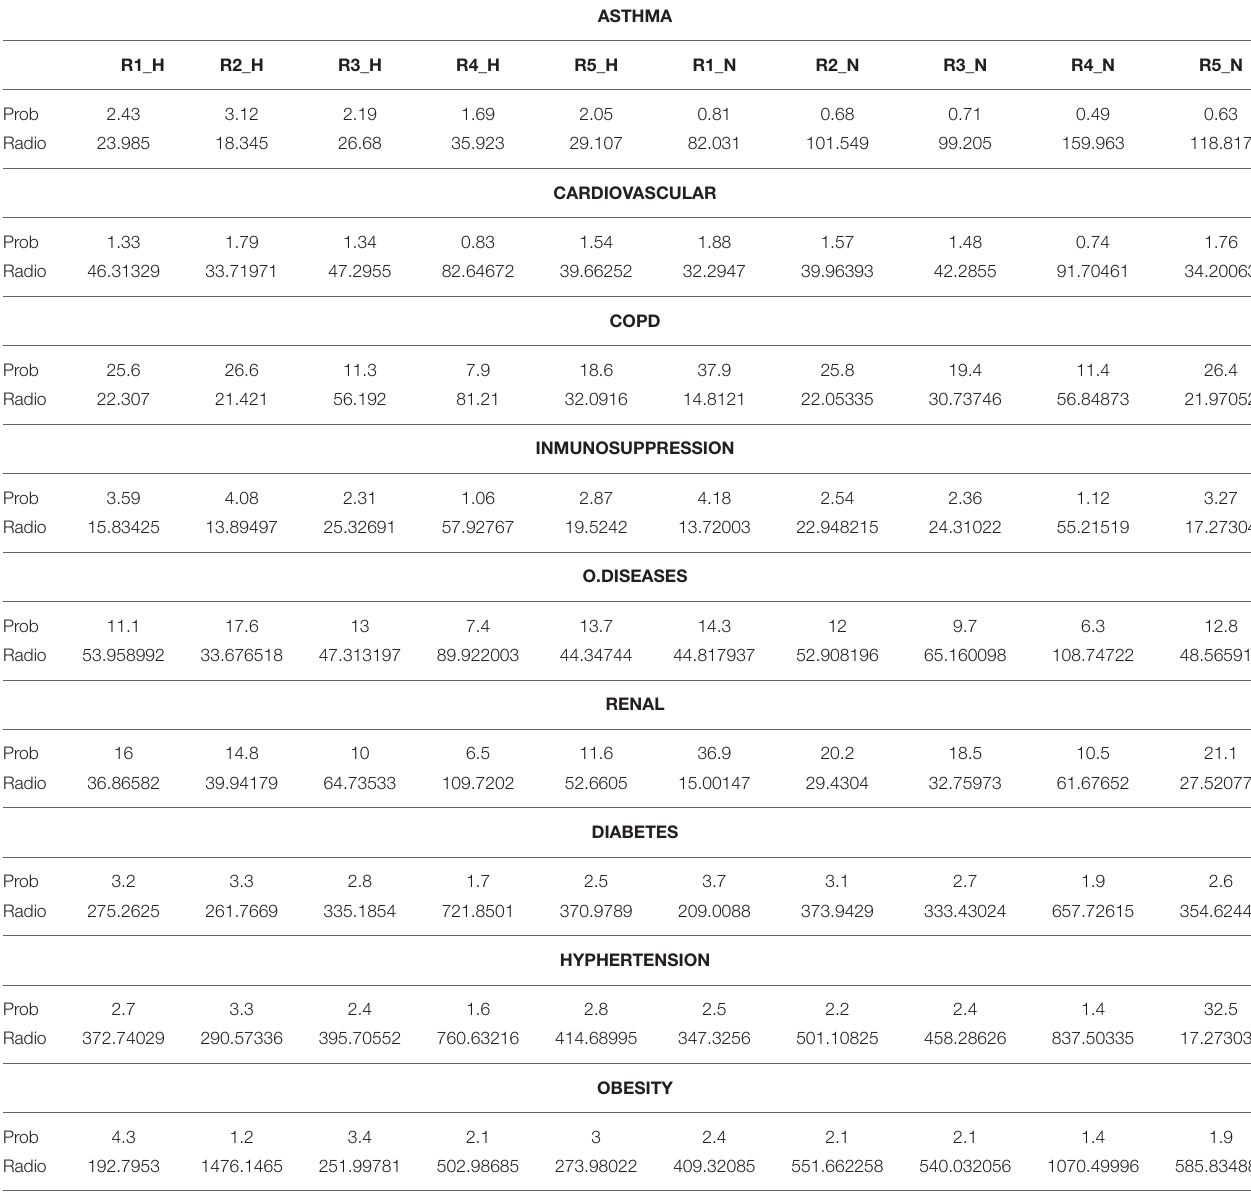
TABLE 1 | Maximum values of probability and radius of the Wigner semicircles, of the 9 comorbidities reported in